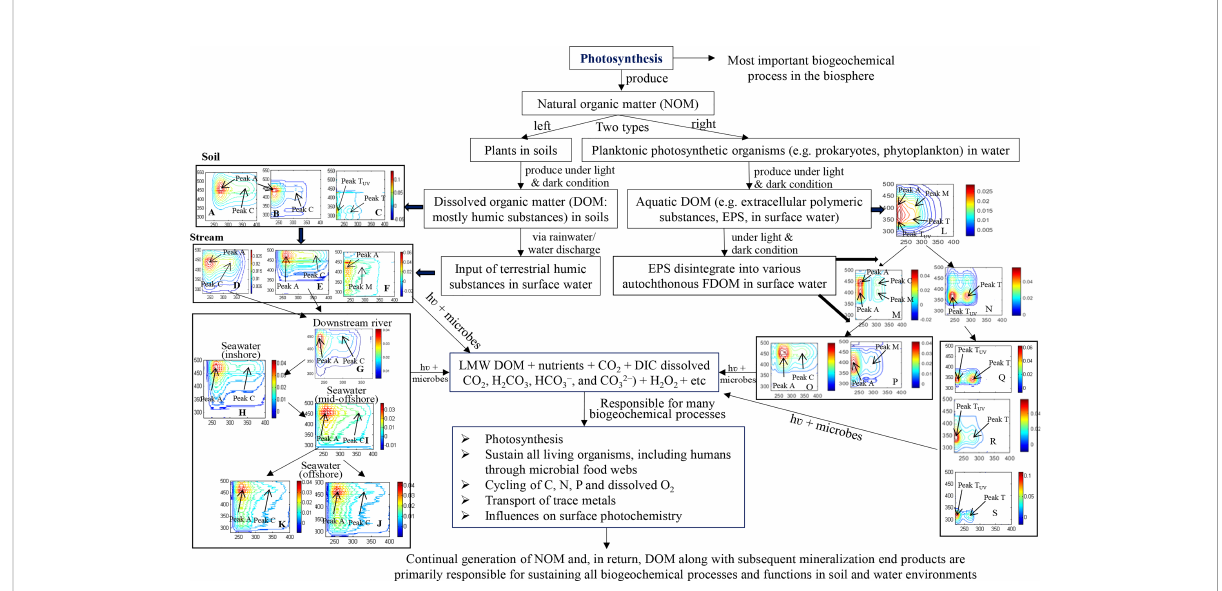
FIGURE 1 Flow diagram of the overall sequential constant photosynthetic production of natural organic matter (NOM) from terrestrial plants, animals and microorganisms in soils, and from planktonic photosynthetic organisms in waters. Figure 1, left: origin of soil humic substances [humic acids-HA (A) , fulvic acids-FA (B) and protein-like substances-PLS (C) ] from terrestrial NOM and their subsequent runoff/leaching into surface waters, fi rst into streams [terrestrial HA-like (D) , terrestrial FA-like (E) , terrestrial PLS-like (F) ], then into downstream river (only terrestrial HA-like substances, (G) , then into inshore seawater ( (H) , 0-10 m depth) and mid-offshore seawater ( (I) , 0-10 m depth), and fi nally into offshore upper ( (J) , 0-15 m) and deeper (K) , 20-300 m) seawaters in Seto Inland Sea. Figure 1, right: origin of extracellular polymeric substances (EPS, (L) from phytoplankton and their subsequent degradation, fi rst into a combined form of autochthonous HA-like substances (AHLS) of C- and M-types (M) and a newly-released autochthonous protein-like substances (APLS, (N) , then into their individual components, i.e. AHLS into C-type (O) and M-type (P) and APLS into protein-like substances (Q) , tryptophan-like substances (R) , tyrosine-like substances (S) , etc. During all transformation described above for the two DOM systems mineralization end products are constantly produced, with the exception of terrestrial HA-like substances that ultimately did not degrade entirely, whereas autochthonous DOM is entirely degraded over one diurnal 24-h cycle by daytime sunlight-induced and nighttime microbial